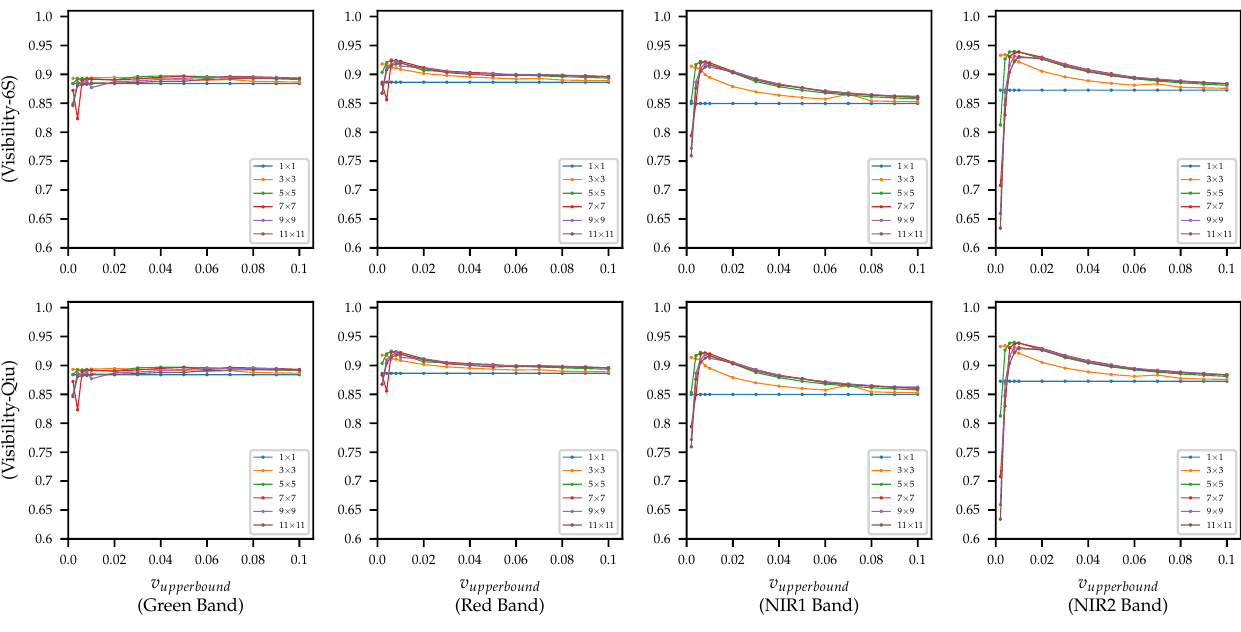
Figure 8. Relationship between v upper bound and R 2 with different receptive